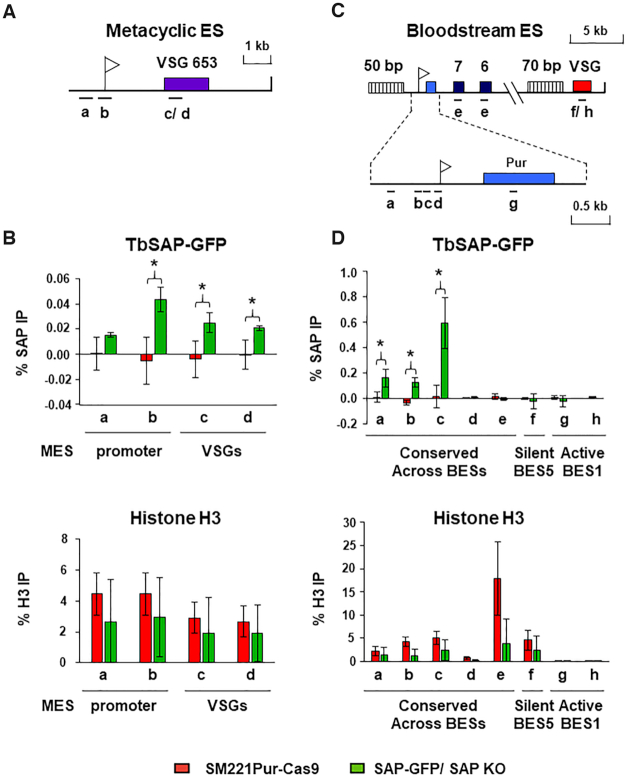
TbSAP is enriched at the promoter regions of metacyclic and bloodstream form ESs. (A) Schematic of a telomeric metacyclic ES (MES) with the promoter indicated with a white flag and the metacyclic VSG653 gene with a purple box. Primer pairs used for analysis of chromatin immunoprecipitated (ChIP) material are indicated with lettered bars. Primer pair ‘c’ recognises VSG653 and primer pair ‘d’ recognises VSG397 present within a different MES. (B) The level of SAP-GFP present at MESs in the SAP-GFP/SAP KO line (green bars), which has one allele of TbSAP epitope tagged with eGFP, and the other TbSAP allele knocked out. In comparison, the same ChIP was performed with the parental cell line (T. brucei SM221 Pur-Cas9) (red bars) which does not contain epitope tagged TbSAP. In the top graph the ChIP was performed with an anti-GFP antibody. In the lower graph ChIP was performed using anti-histone H3 antibodies. Results are presented as the percentage of the total input immunoprecipitated after subtraction of a no antibody control. Data for the ChIP experiments is the mean of three biological replicates, with the standard deviation indicated with error bars. Statistical significance (pair-wise t-test against ChIP material from the untagged parental SM221pur cells) is indicated with asterisks (*P< 0.05). (C) Schematic of bloodstream form ES (BES1) with a puromycin resistance gene (blue box) inserted behind the active BES1 promoter (white flag). Expression site associated genes (ESAG) 7 and 6 are indicated with numbered boxes, and VSG221 with a red box. Simple sequence repeats (50 or 70 bp) are indicated with vertically striped boxes. An enlargement of the BES promoter region is indicated below. Primer pairs a–e (indicated with bars) are conserved across all BESs, while primer pairs f-h are specific for sequences present within either the active BES1 (VSG221, primer pair ‘f’ and puromycin, primer pair ‘g’) or the silent BES5 (VSG800 or VSG-18, primer pair ‘h’) respectively. (D) The ChIP experiments were performed as detailed in panel (B) only the distribution of SAP-GFP or histone H3 was determined across BESs in either the T. brucei SAP-GFP/ SAP KO line, or the untagged parental T. brucei SM221Pur-Cas9 cell line.